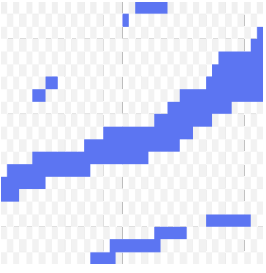
Figure 16. Grid 15 × 15 (manual best case).